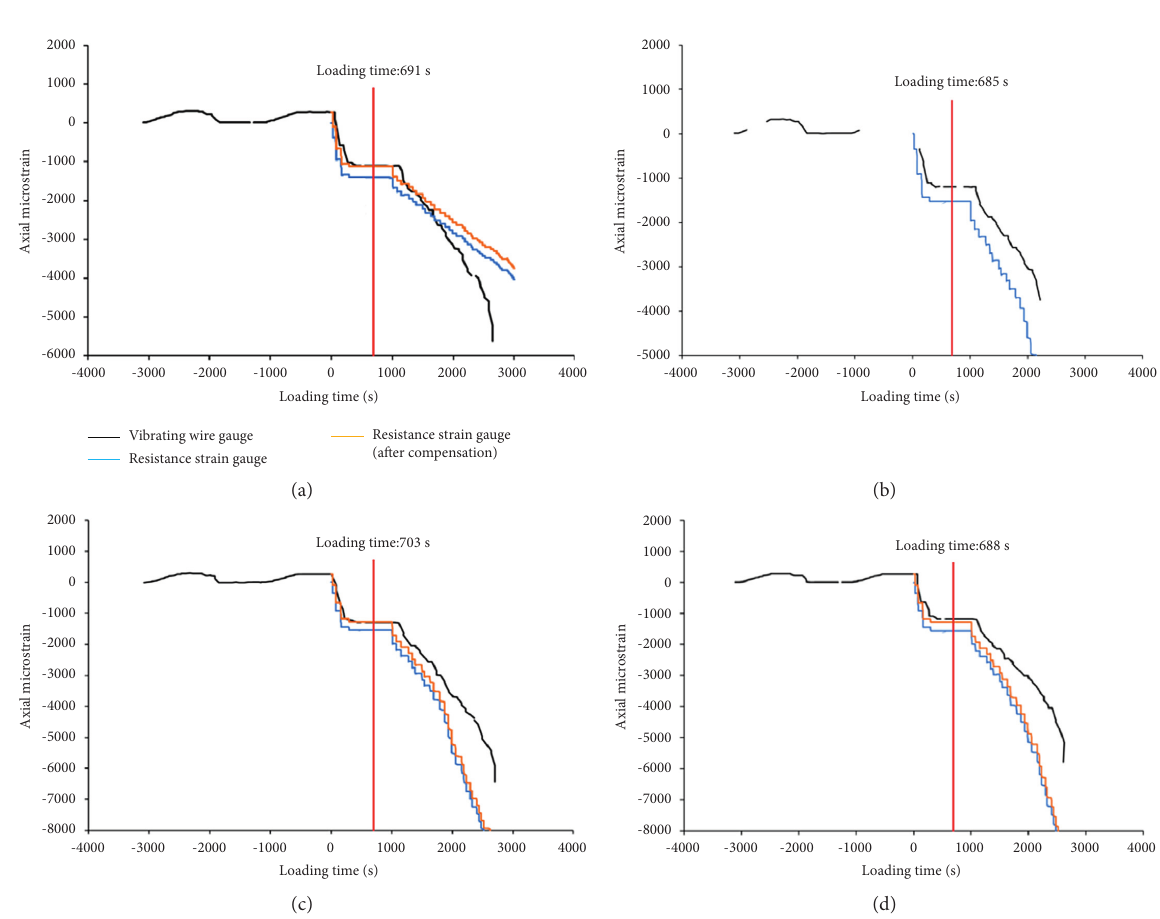
Figure 11: Comparison of results between VWGs and SGs (the red vertical line stands for the loading time): (a) section 2; (b) section 3; (c) section 4; (d) section